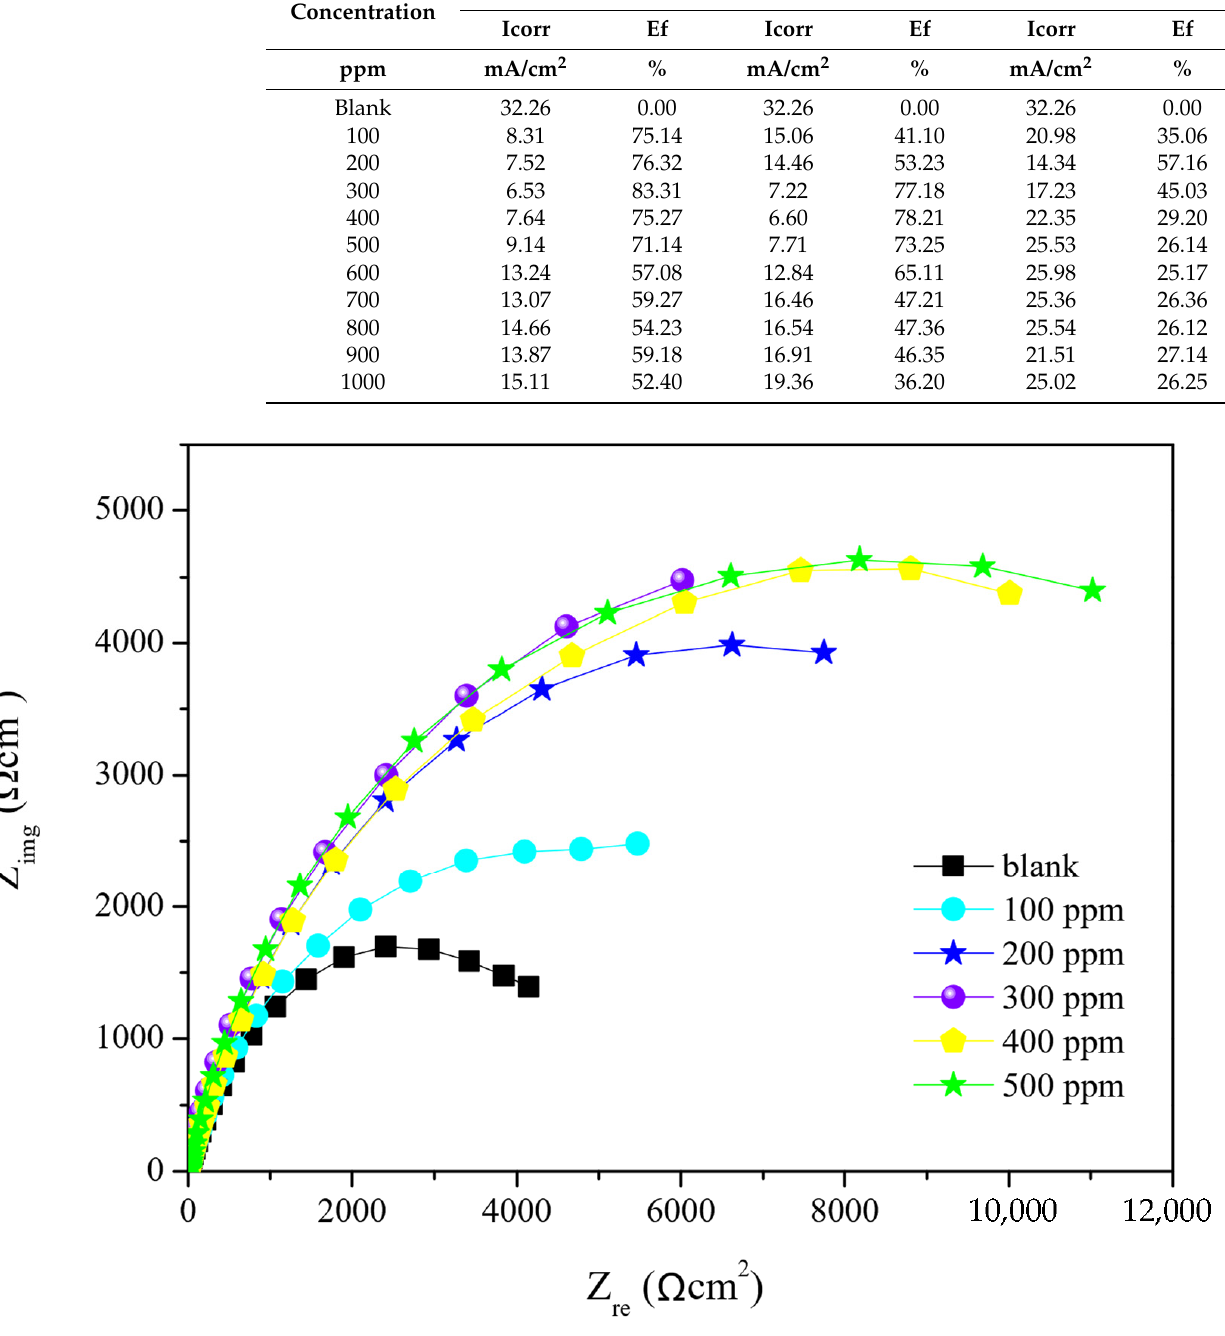
Figure 6. Nyquist impedance curves of the Pex 50%–Gx 50% formulation applied to the medium in different concentrations. different